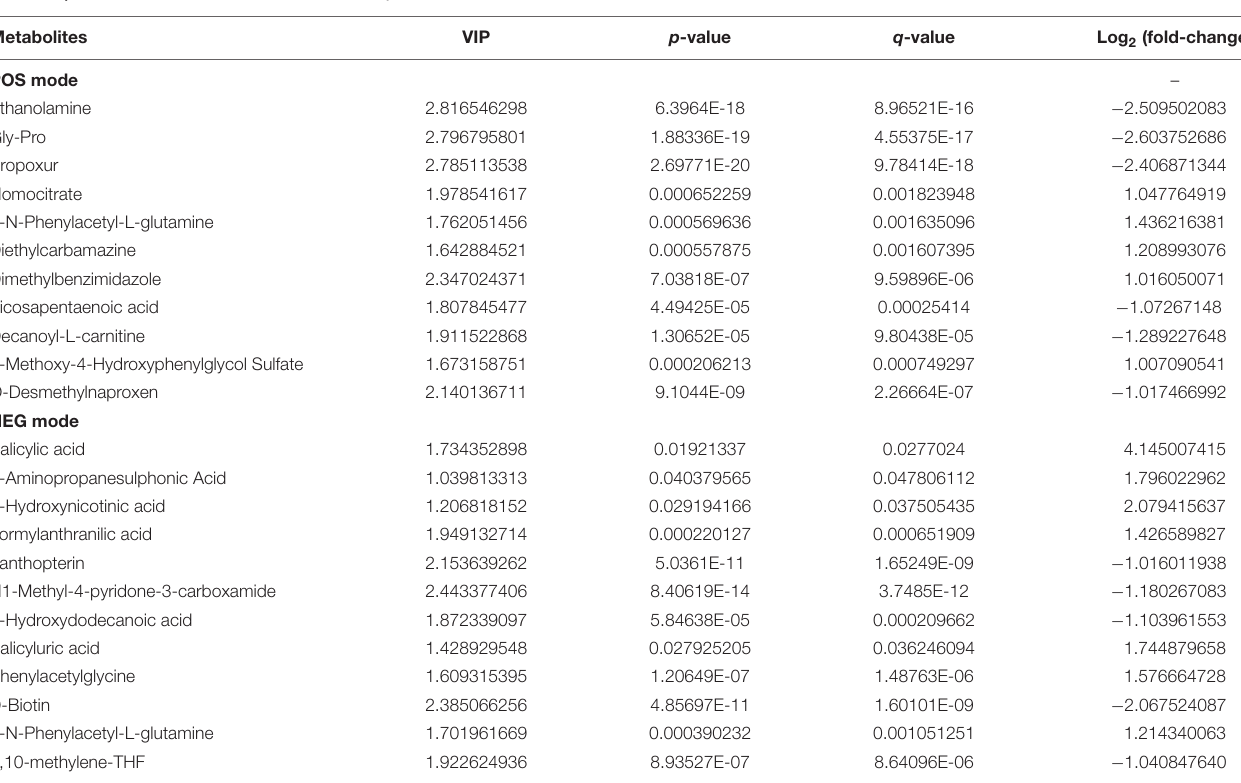
TABLE 3 | Differential metabolites for correlation